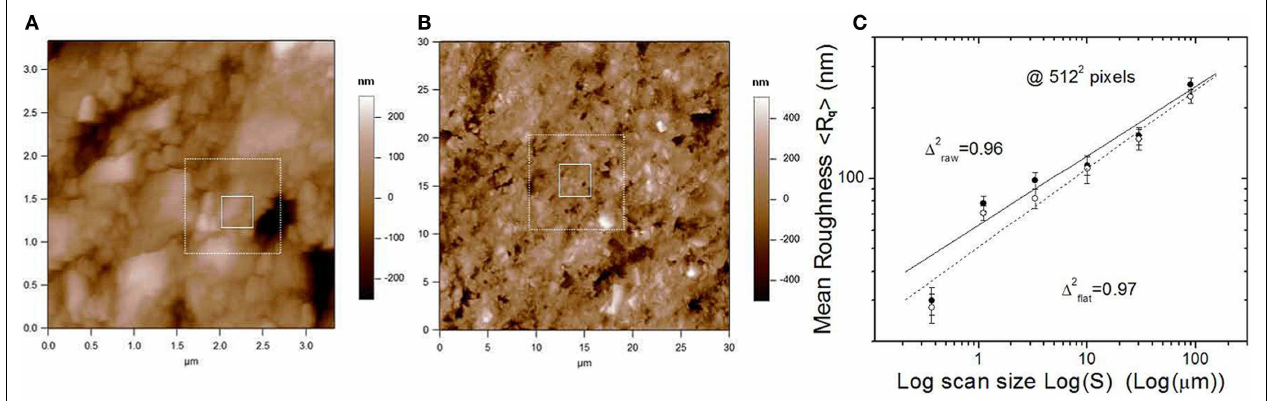
plot of RMS roughness obtained from the images vs. the scan size: when a straight fits well enough the trend over the whole scan size range, the surface is fractal and the slope describes the fractal dimension. Reprinted from Salerno et al. (2010a).